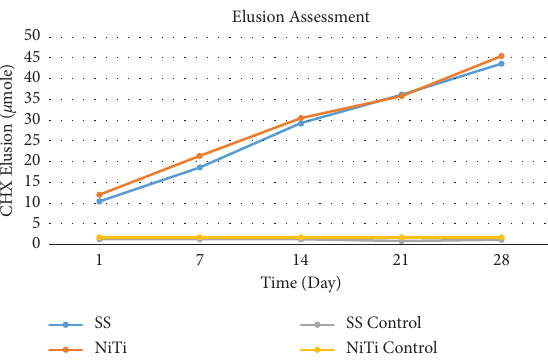
Figure 12: Elusion of accumulative CHX from coated SSW and NiTiW along 28days compared with the control